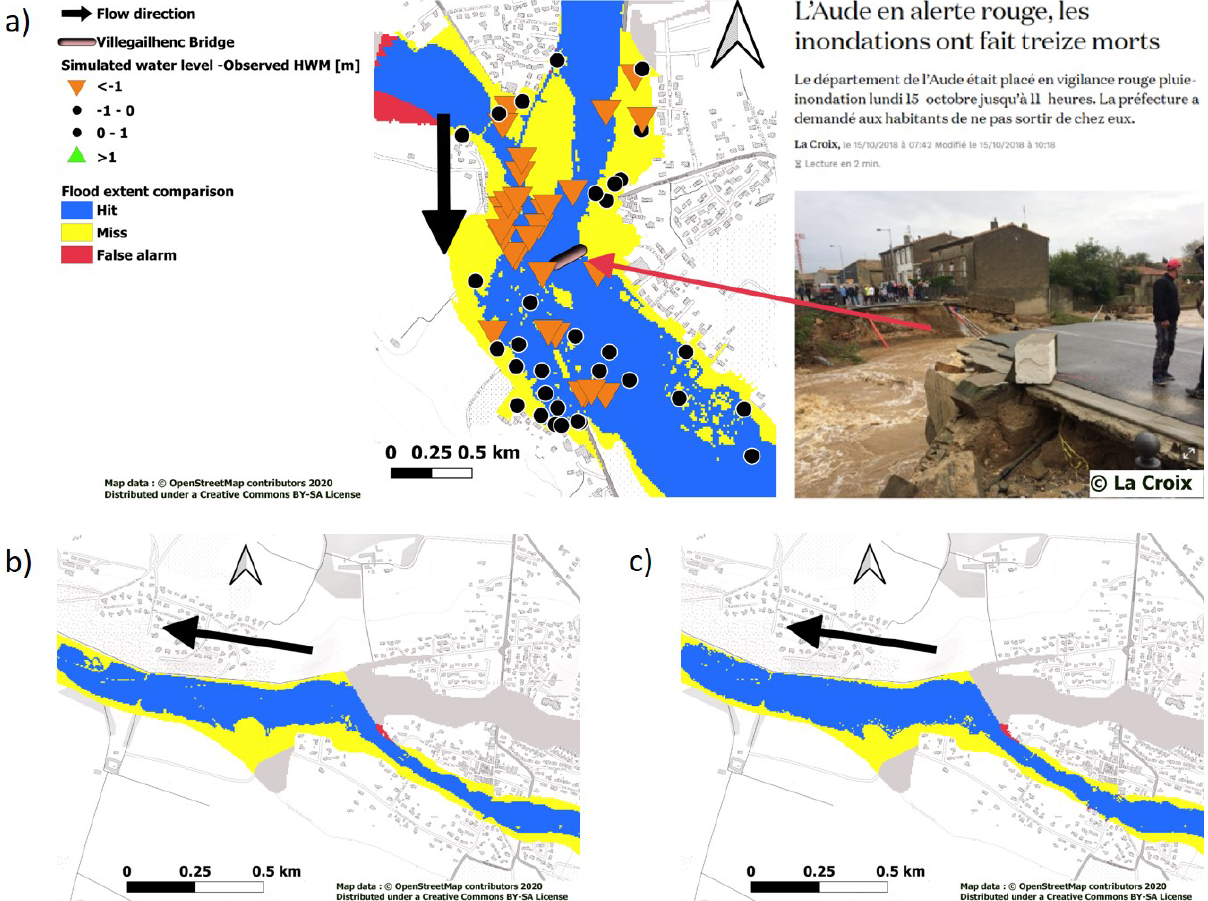
Figure 9. Illustration of large water levels underestimations. (a) Trapel river at Villegailhenc, with the simulation results (Floodos model) and a picture of the bridge destroyed by the flood. (b) Fount Guilhen river at Cazilhac and simulation results (Floodos model), with the initial discharge value (84.2m 3 s − 1 corresponding to a curve number (CN) value of 70 in the Cinecar rainfall–runoff model). (c) Fount Guilhen river at Cazilhac and simulation with a modified discharge (116.5m 3 s − 1 ; CN value of